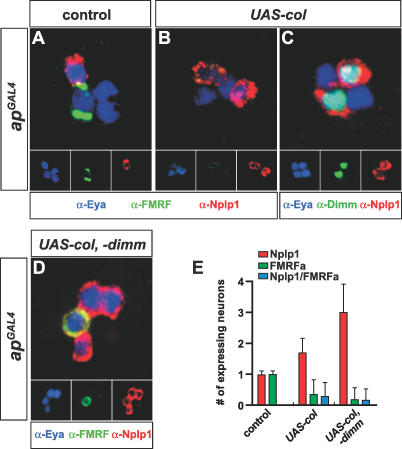

col Misexpression in the Ap Cluster Triggers Ectopic Nplp1 Expression(A) In the control, the Ap cluster (here visualized by Eya) contains one FMRFa- and one Nplp1-expressing cell.(B and C) Misexpression of col in the Ap cluster triggers ectopic Nplp1 expression in one additional Ap cluster neuron. Labeling for FMRFa (B) and for Dimm (C) reveals that this cell is the Tv neuron, evident from its co-expression of Nplp1, FMRFa (B), and Dimm (C).(D) Co-misexpression of col and dimm in the Ap cluster triggers all four Ap cluster neurons to express Nplp1. Misexpression of dimm has no effect upon Nplp1 expression (unpublished data).(E) Quantification of Nplp1, FMRFa, and Nplp1/FMRFa expression (n > 80 thoracic hemisegments).All images are from 18-h AEL VNCs.Genotypes: (A) w1118, (B and C) apGAL
4
/+; UAS-col/+, and (D) apGAL4/+; UAS-col, UAS-dimm/+. (E) Control is w1118.